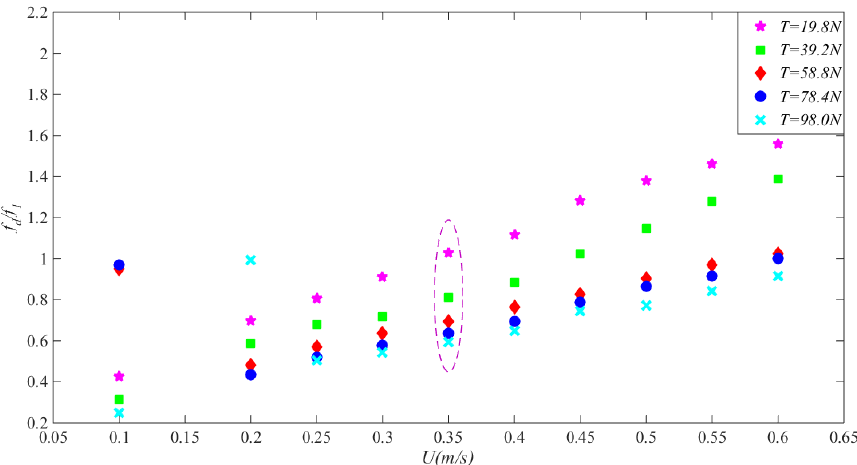
Figure 7. The dimensionless dominant frequency of VIV in the direction of cross-flow varies with the outflow velocity under different top tension.